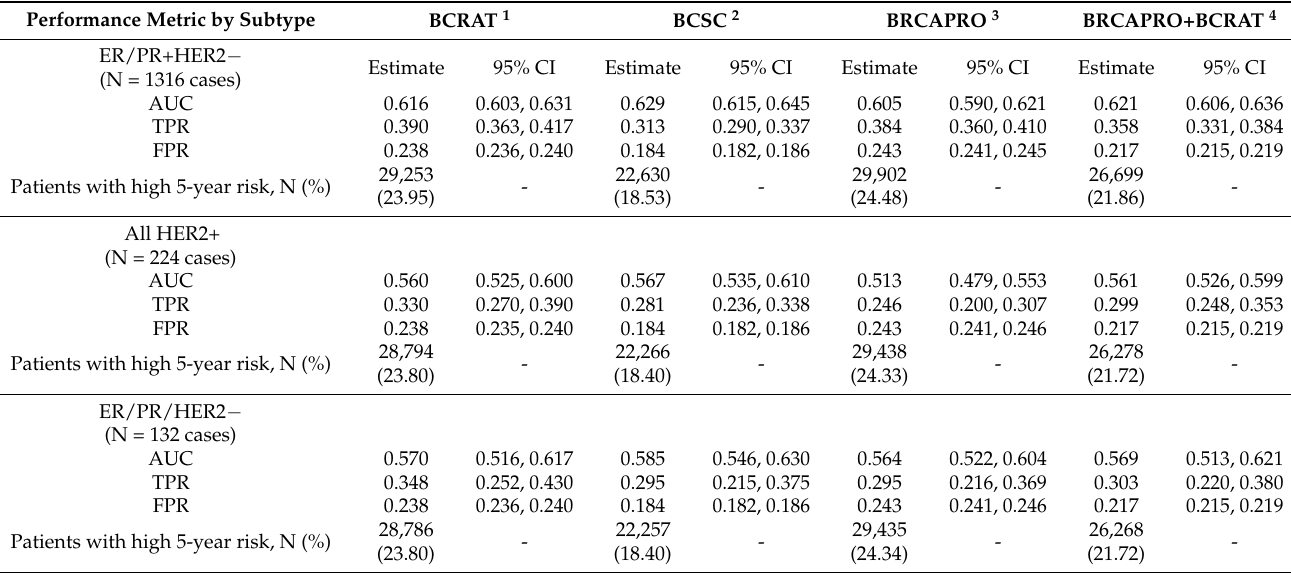
Table 4. Performance of risk models by molecular